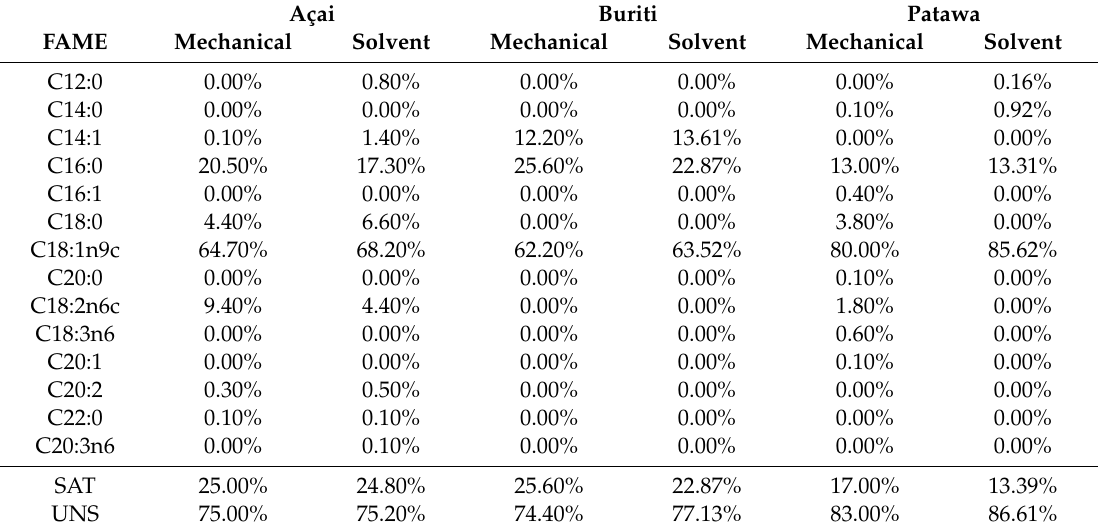
Table 3. Fatty acid methyl ester (FAME) profiles for açai, buriti and patawa oils obtained by mechanical and solvent extraction. Açai Buriti Patawa FAME Mechanical Solvent Mechanical Solvent